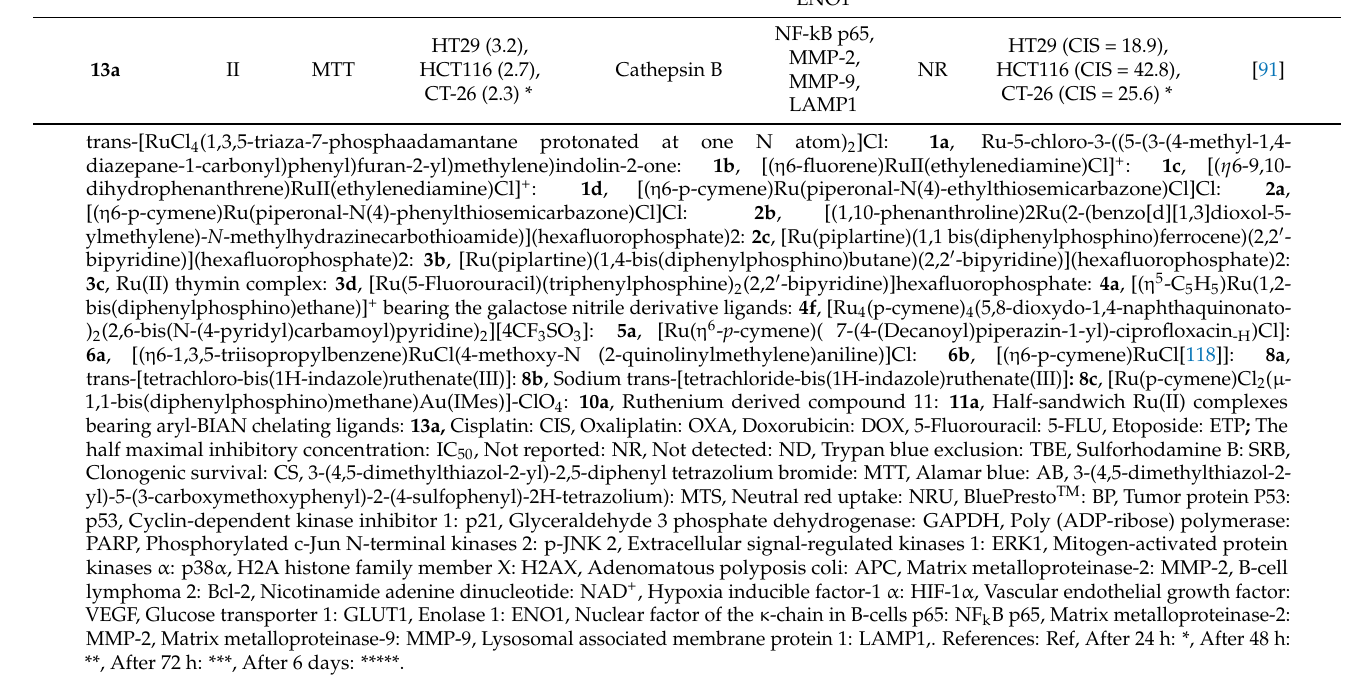
PARP, Phosphorylated c-Jun N-terminal kinases 2: p-JNK 2, Extracellular signal-regulated kinases 1: ERK1, Mitogen-activated protein kinases α : p38 α , H2A histone family member X: H2AX, Adenomatous polyposis coli: APC, Matrix metalloproteinase-2: MMP-2, B-cell lymphoma 2: Bcl-2, Nicotinamide adenine dinucleotide: NAD + , Hypoxia inducible factor-1 α : HIF-1 α , Vascular endothelial growth factor: VEGF, Glucose transporter 1: GLUT1, Enolase 1: ENO1, Nuclear factor of the κ -chain in B-cells p65: NF k B p65, Matrix metalloproteinase-2: MMP-2, Matrix metalloproteinase-9: MMP-9, Lysosomal associated membrane protein 1: LAMP1,. References: Ref, After 24 h: *, After 48 h: **, After 72 h: ***, After 6 days: